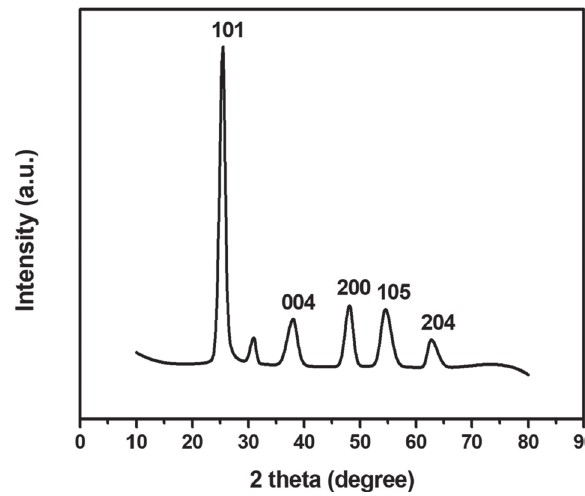
nanoparticles; (b) Zeta potential 2